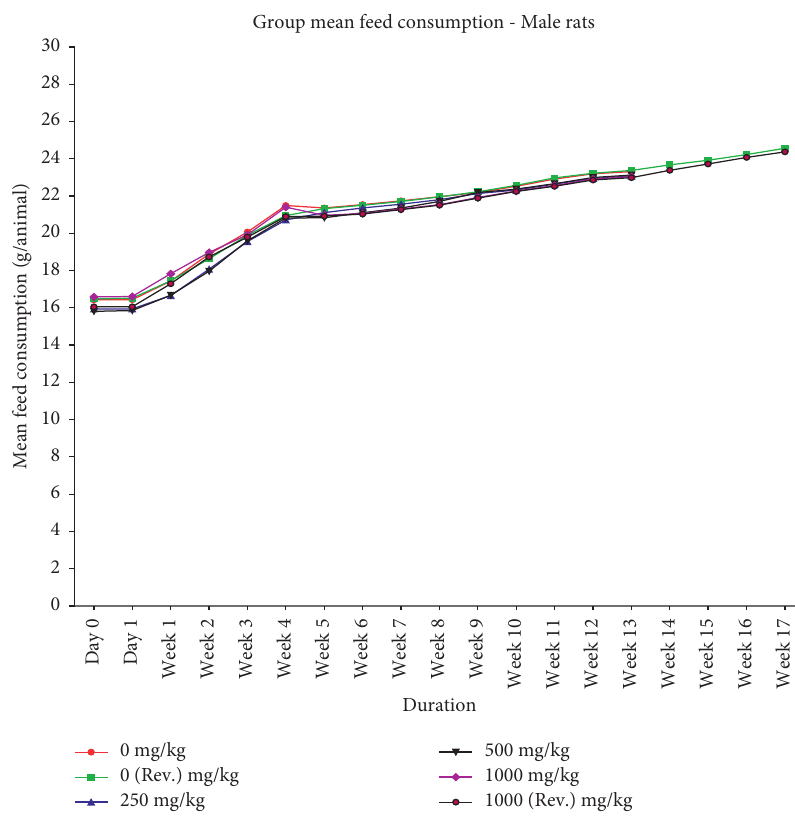
Figure 3: Group mean feed consumption (mean ± SD) of male rats orally administered with GutGard for 90 days ( n � 10; n � 5 for reversal groups; p ≤ 0 .